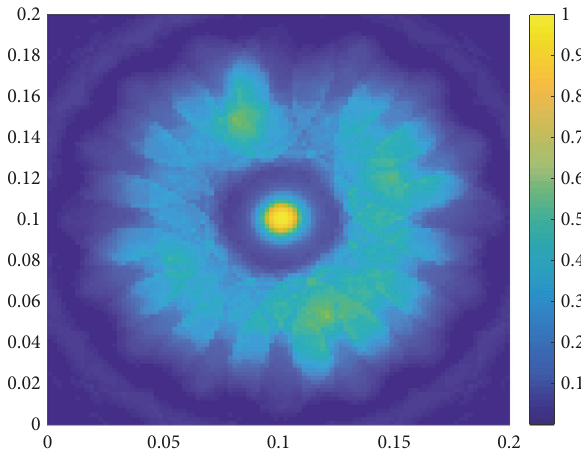
Figure 8: Image of the air defect model after